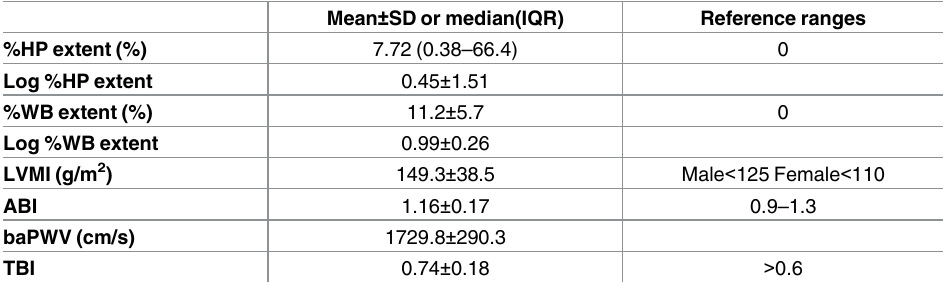
Table 2. Results of %HP extent, %WB extent and surrogates of atherosclerosis. Mean ± SD or median(IQR) Reference ranges %HP extent (%) 7.72 (0.38–66.4) 0 Log %HP extent 0.45 ± 1.51 %WB extent (%) 11.2 ± 5.7 0 Log %WB extent 0.99 ± 0.26 LVMI (g/m 2 ) 149.3 ± 38.5 Male < 125 Female < 110 ABI 1.16 ± 0.17 0.9–1.3 baPWV (cm/s) 1729.8 ± 290.3 TBI 0.74 ± 0.18 > 0.6 HD patient showed median %HP extent 7.72%, and median %WB extent 11.2%. Also, they showed